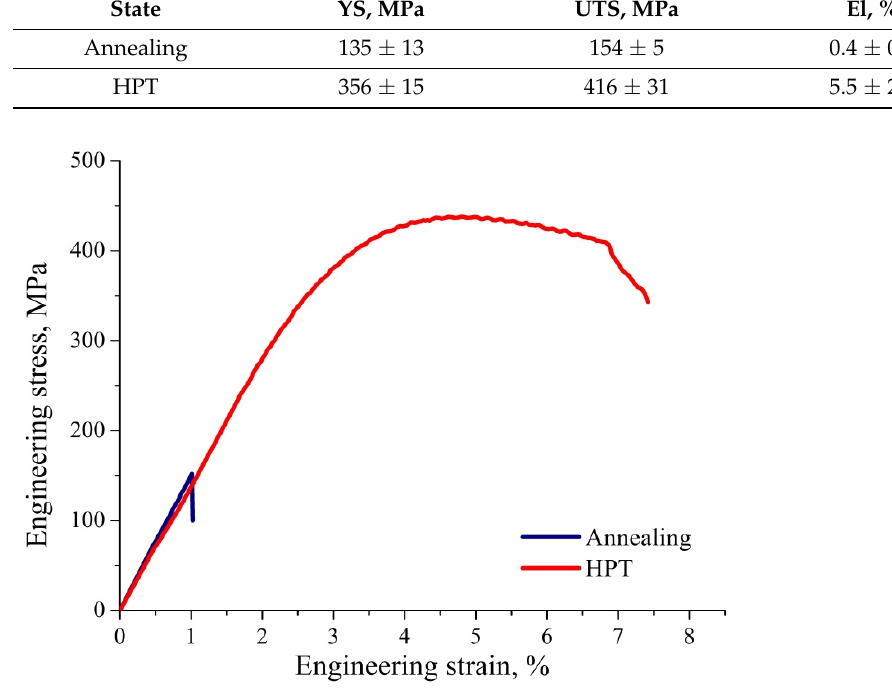
Figure 6. Engineering stress–strain response of Zn-1%Mg-0.1%Ca alloy before and after